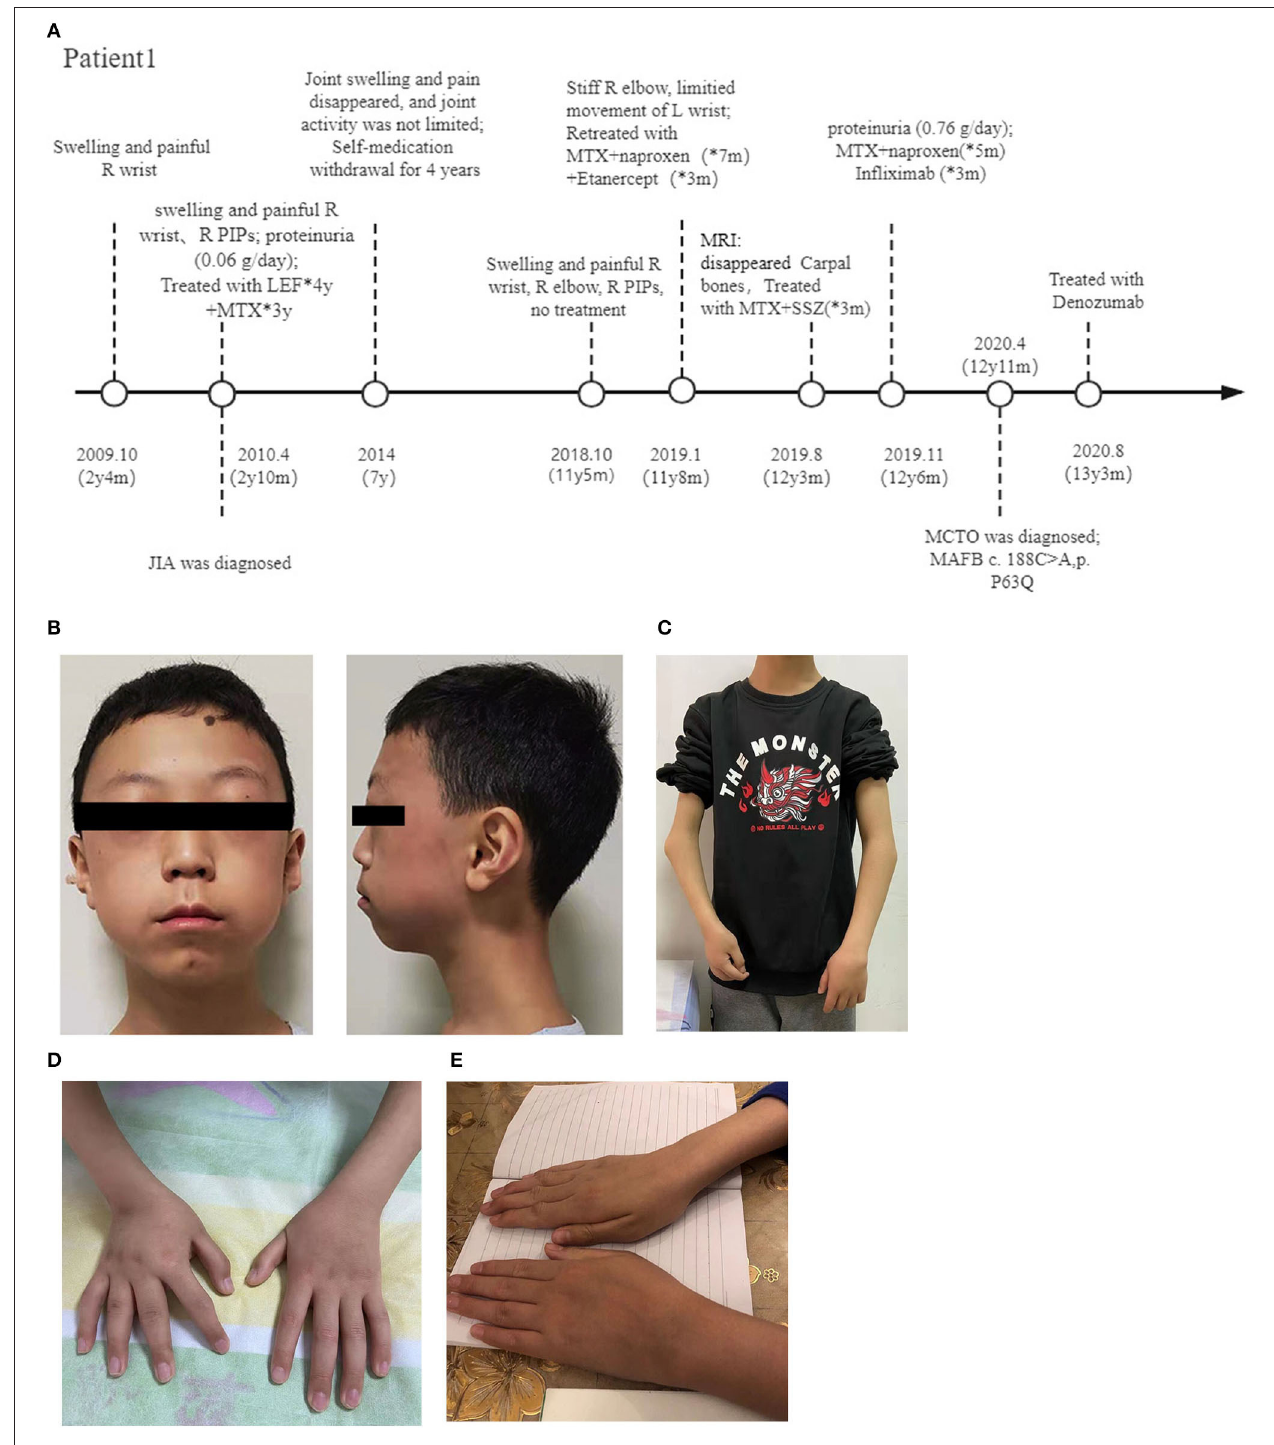
FIGURE 1 | Photographs of the patients. (A) Diagram of the disease progression of patient 1. (B) Anteroposterior view of patient 1 at 12 years old, showing a triangular face, micrognathia, and a protruding forehead. View of the same patient showing elbow deformities and a short forearm (C) , and ulnar deviation of both wrists (D) . (E) Swollen left wrist of patient 2. R, right; y, year; m, month; PIP, proximal interphalangeal; MTX, Methotrexate; LEF, Leflunomide; SSZ, Sulfasalazine; MCTO, Multicentric carpo-tarsal osteolysis syndrome; MAFB, MAF bZIP transcription factor B.